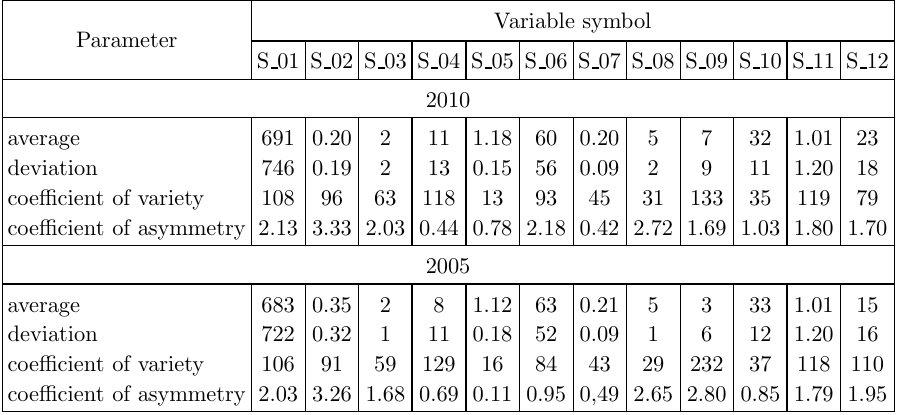
Variable symbol